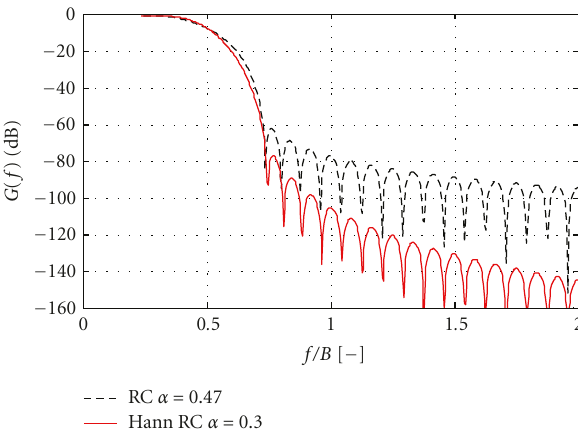
Figure 2: Amplitude frequency characteristics of the truncated RC filter with α = 0 . 47 and its Hann window weighted variant with α = 0 .